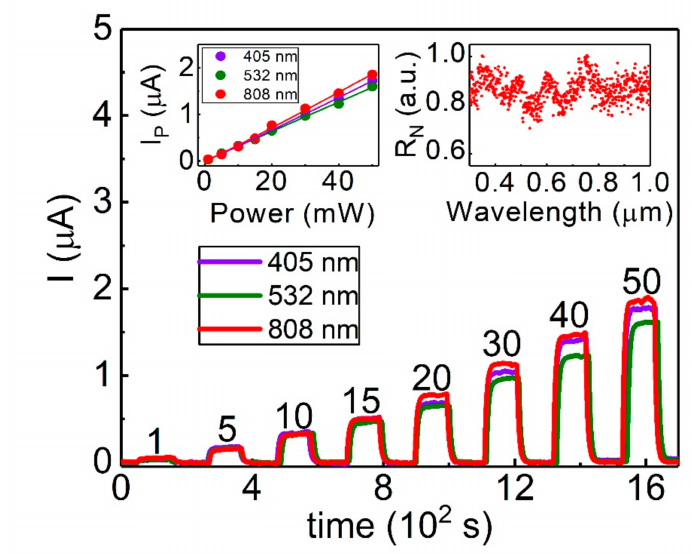
Figure 4. The photocurrent as a function of the light power at three wavelengths. The left-top inset shows that the photocurrent varies linearly with the light power at three wavelengths. The right-top inset shows that the responsivity is insensitive to wavelengths from 300 to 1000 nm.